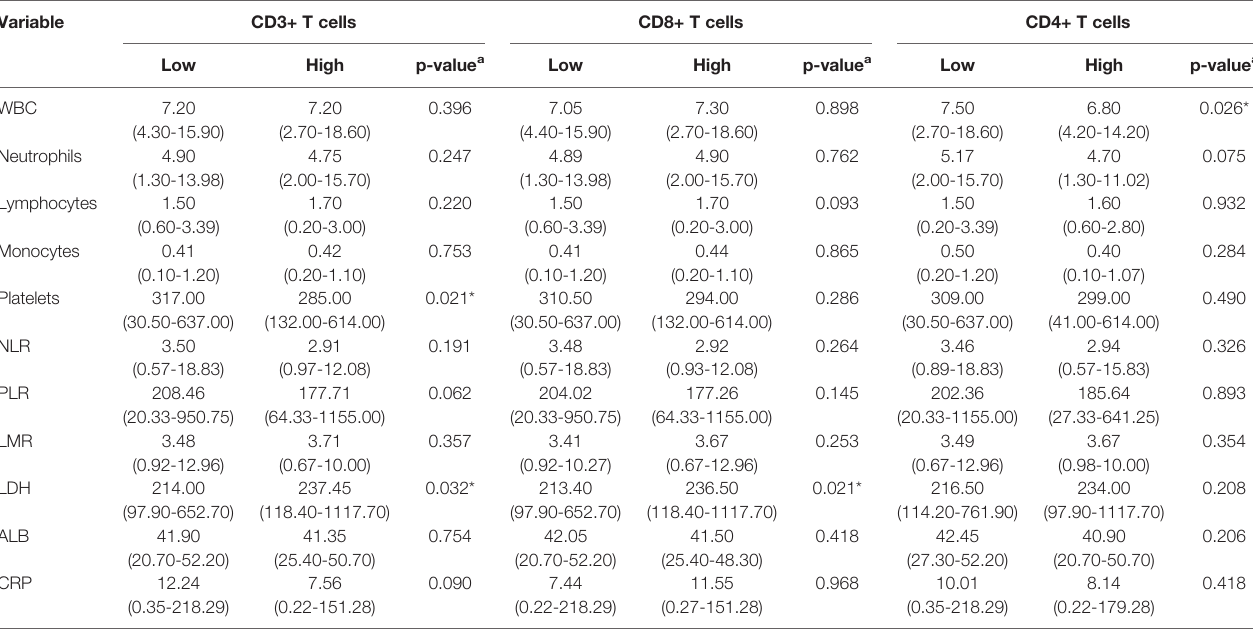
TABLE 3 | Association between in fl ammatory markers and T cells in the microenvironment.